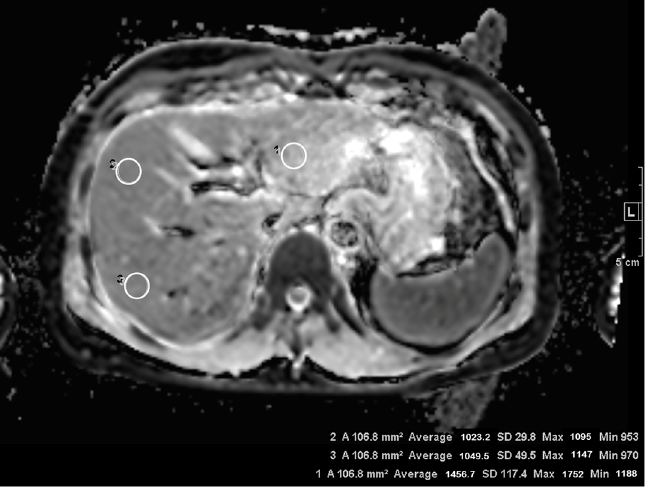
Figure 1. Measurement of apparent diffusion coefficient (ADC) of the hepatic parenchyma on ADC map. Three 1-cm 2 circular regions of interest were manually drawn at the left lobe (1), right anterior segment (2), and right posterior segment (3) of the liver parenchyma.